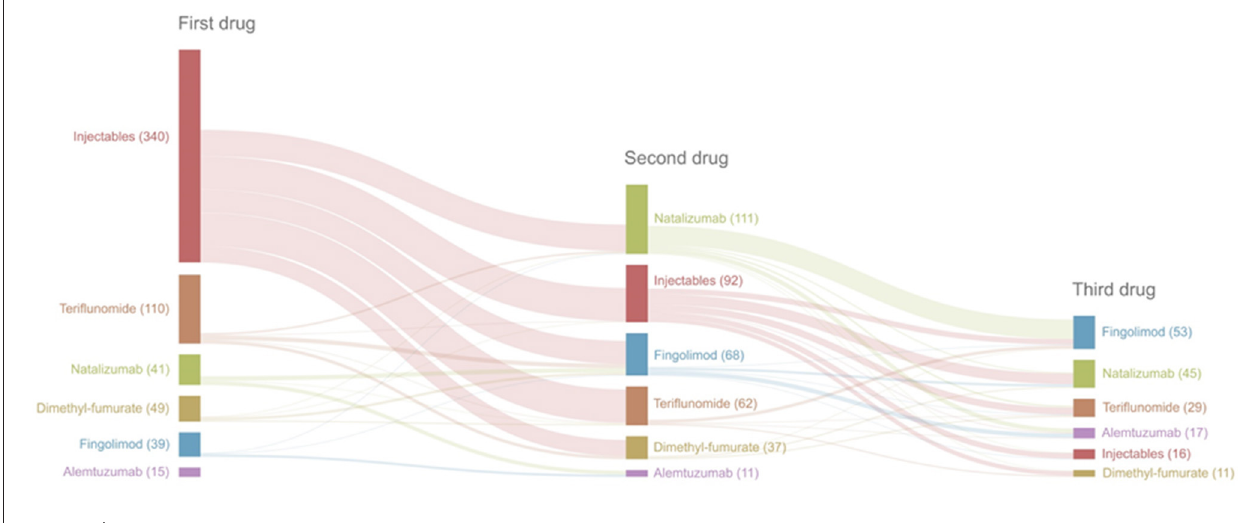
FIGURE 1 | Flow chart of drug swaps.